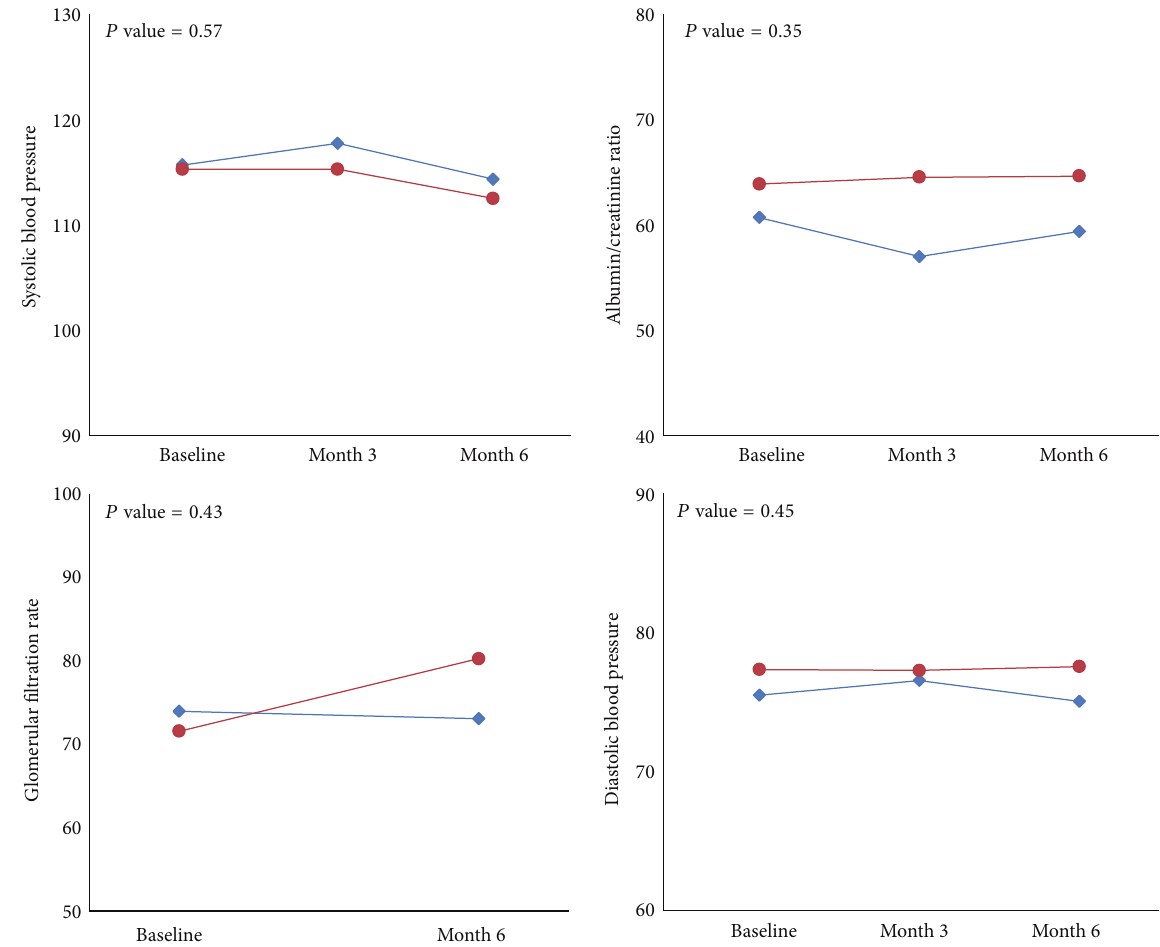
Figure 2: Comparison of trend of studied variables in time points between case and control groups. Case group included 20 patients who received regular medications plus 400mg pentoxifylline. Control group included 20 patients who received regular medications plus